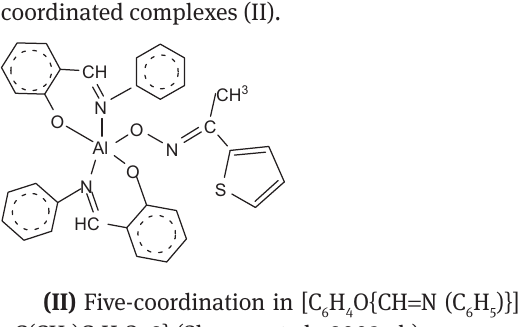
Table 1 IR spectral data (cm -1 ) of [(CH and [(CH